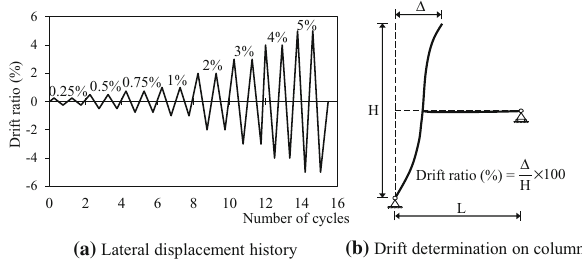
Fig. 11 Loading protocol: a lateral displacement history and b drift determination on column.